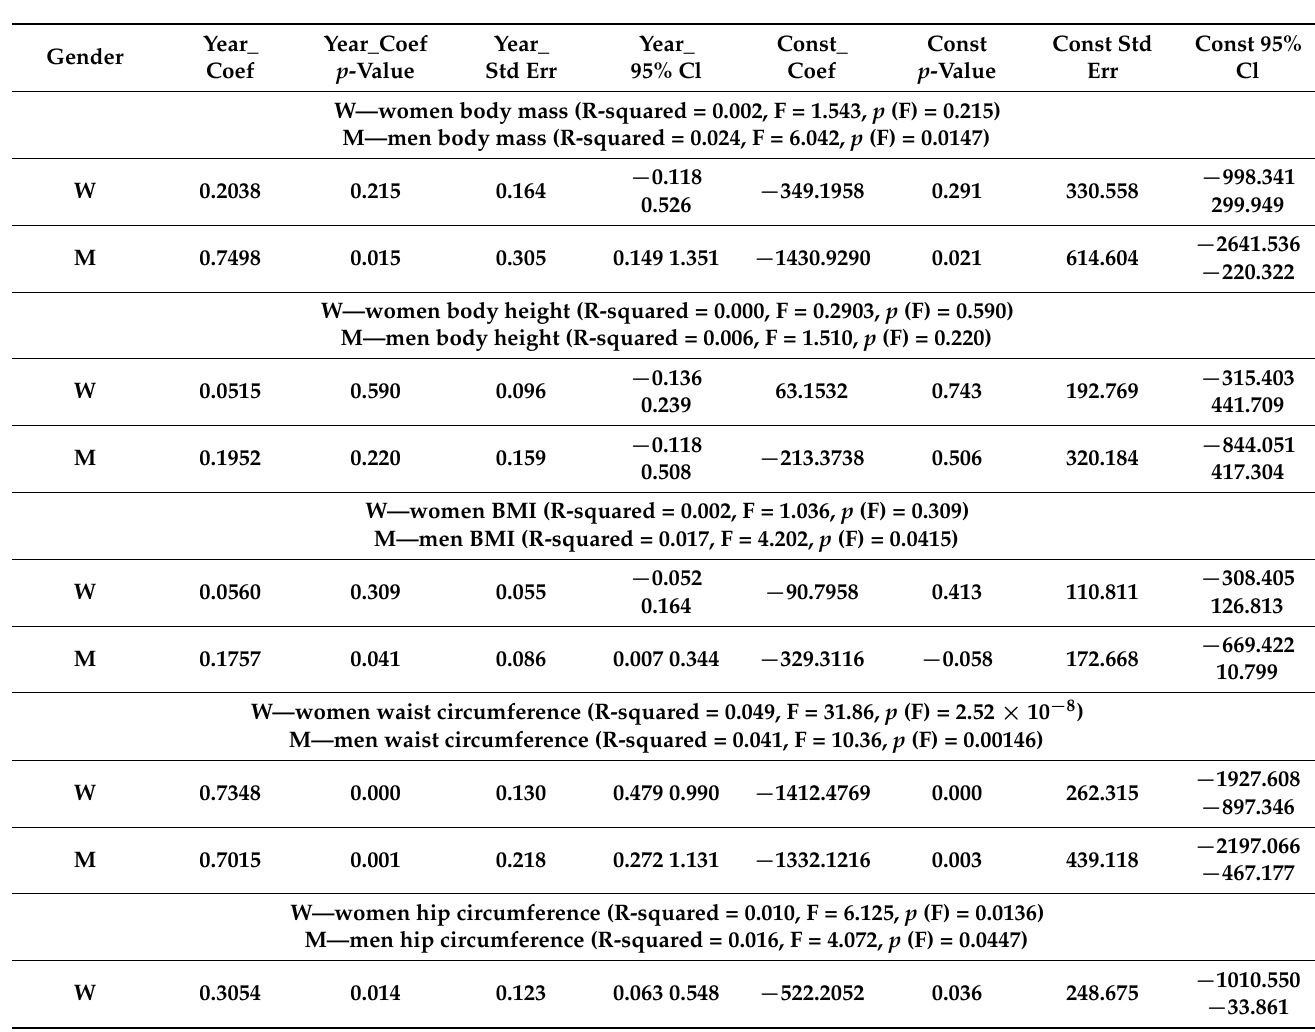
Table 5. The results of the analysis of temporal changes in the examined somatic traits in the